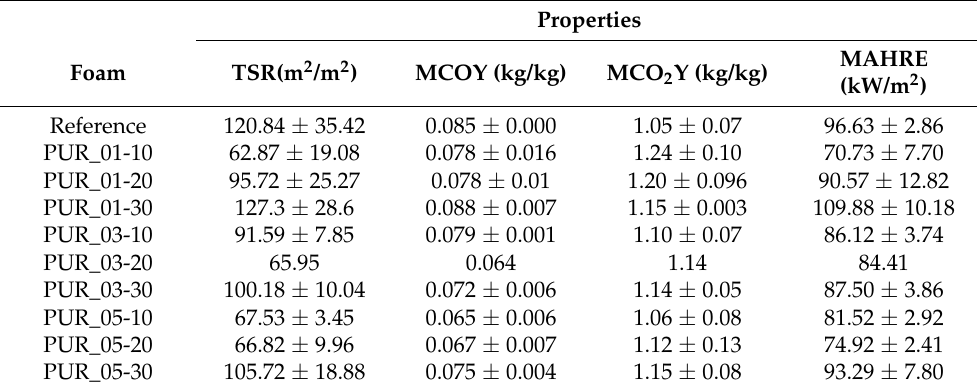
Table 4. Fire retardancy properties of RPUF foams as a function of grain size and reinforcement